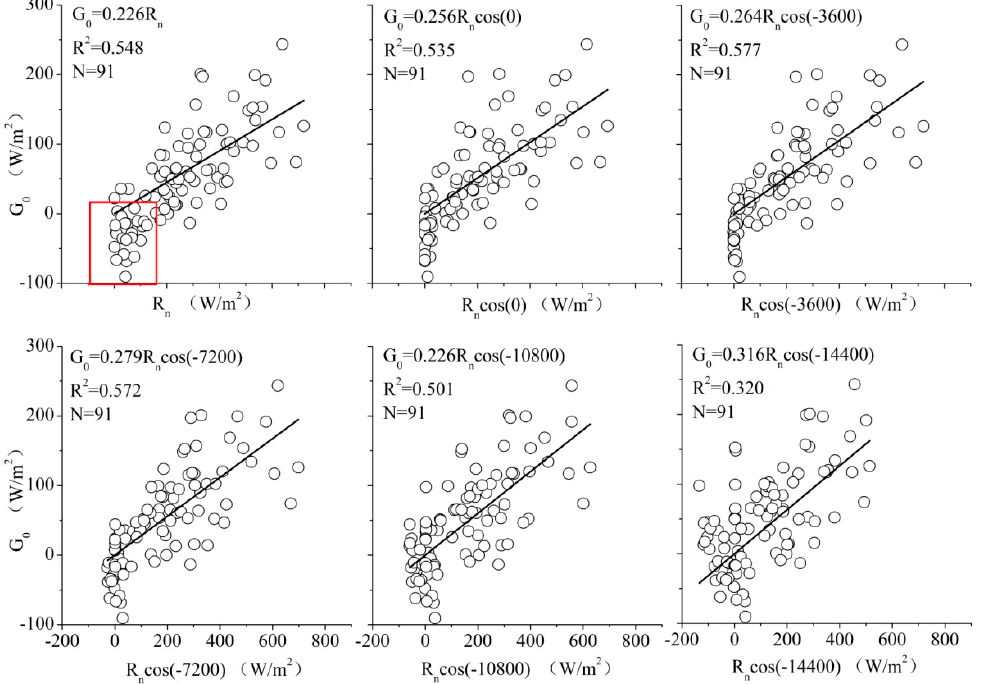
Figure 6. The relationship between G 0 and R n (t) under the different phase shifts at SPAM.